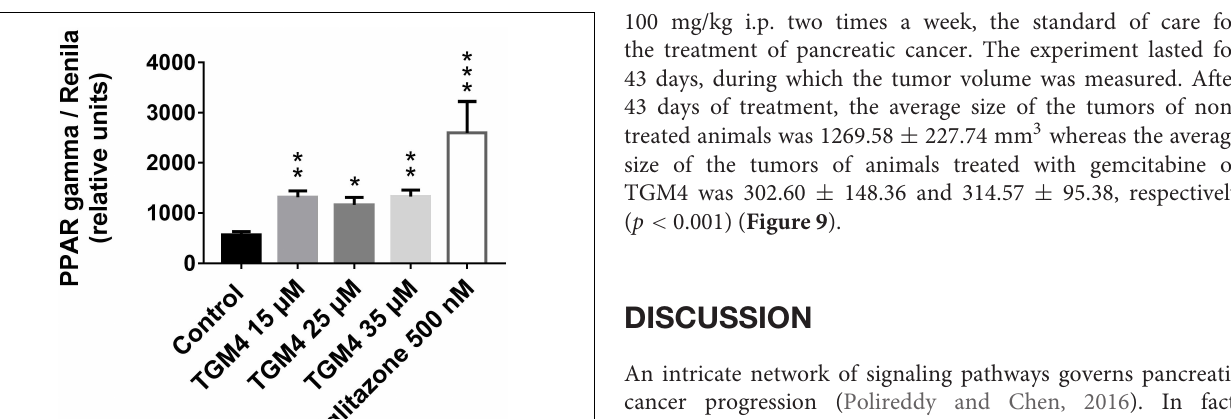
injection of 7.5 × 106 Mia-PaCa-2 cells per mouse.